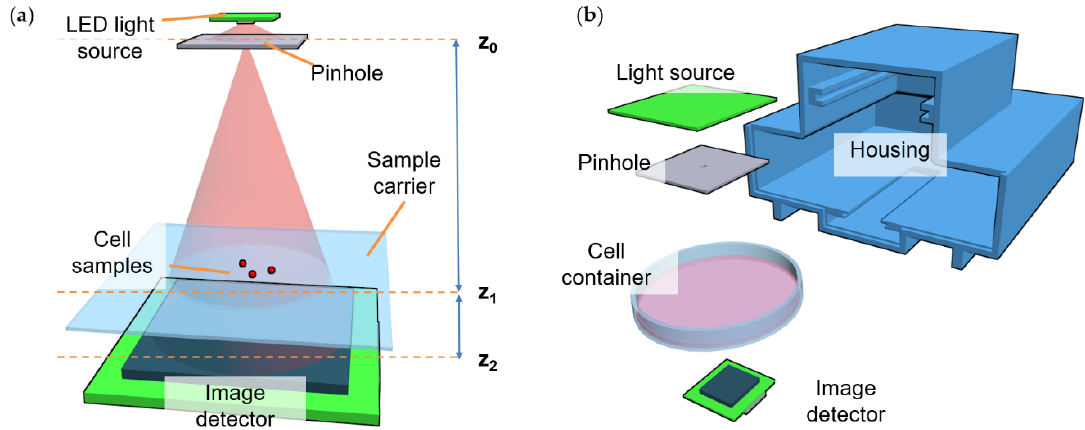
Figure 2. Schemes of the digital inline-holographic microscope (DIHM): ( a ) Principle sketch illustrating the position of the light-emitting diode (LED) light source, cell sample, and image sensor relative to each other; and ( b ) scheme of the full system, including a 3D-printed housing and a petri dish.